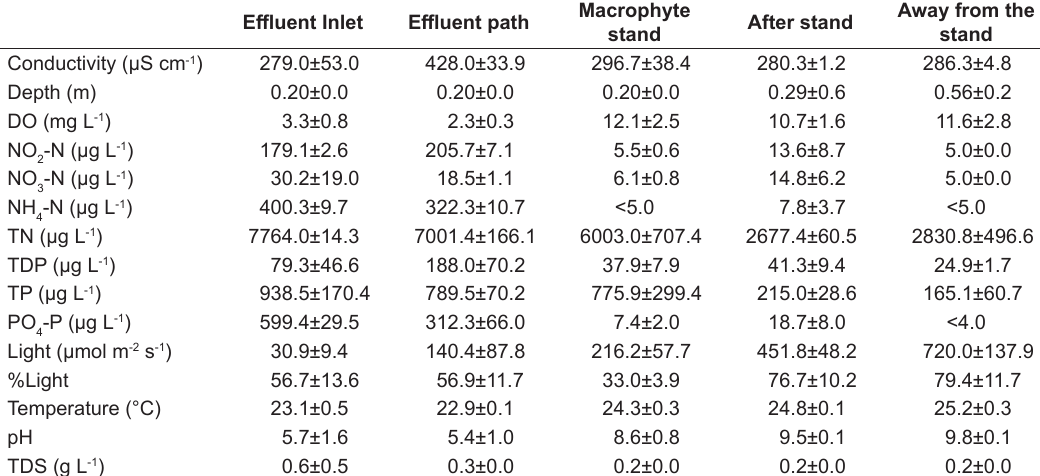
Table 1. Mean and standard deviation of environmental variables in the sampling